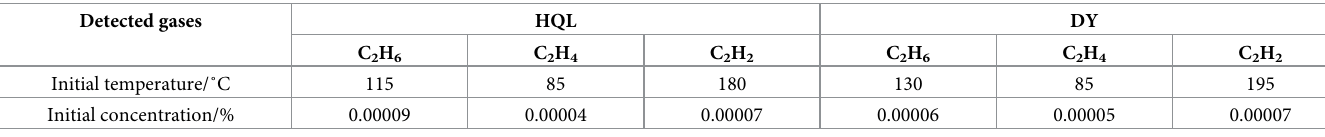
Table 3. Indicative gas output results of coal samples in the heating stage. Detected